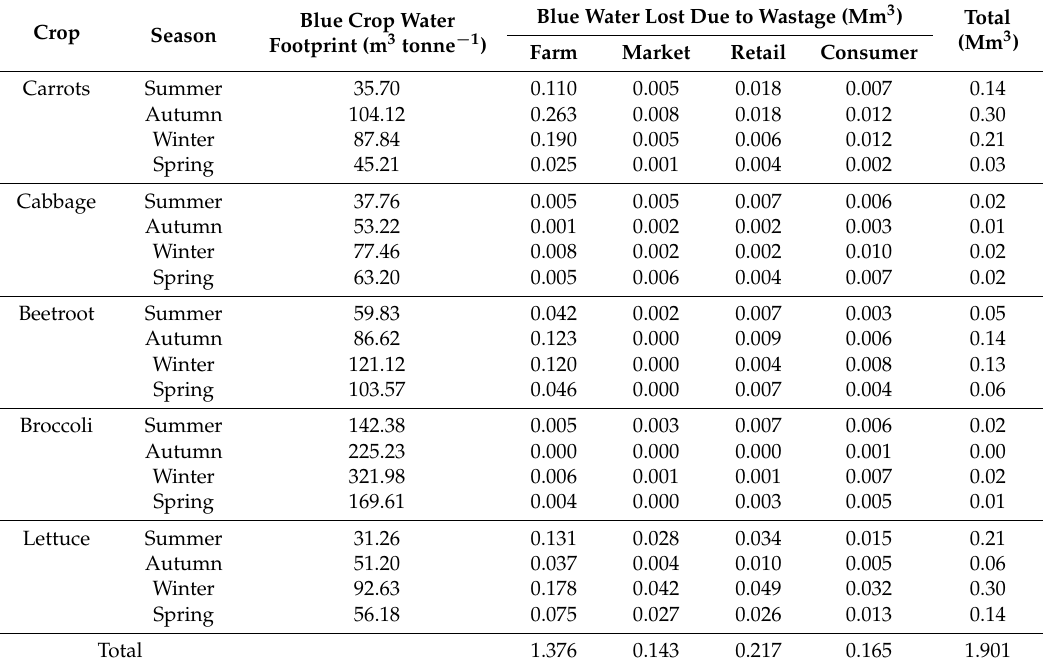
Table 2. Blue water footprints [21] and blue water lost due to wastage of vegetables produced on the Steenkoppies Aquifer in